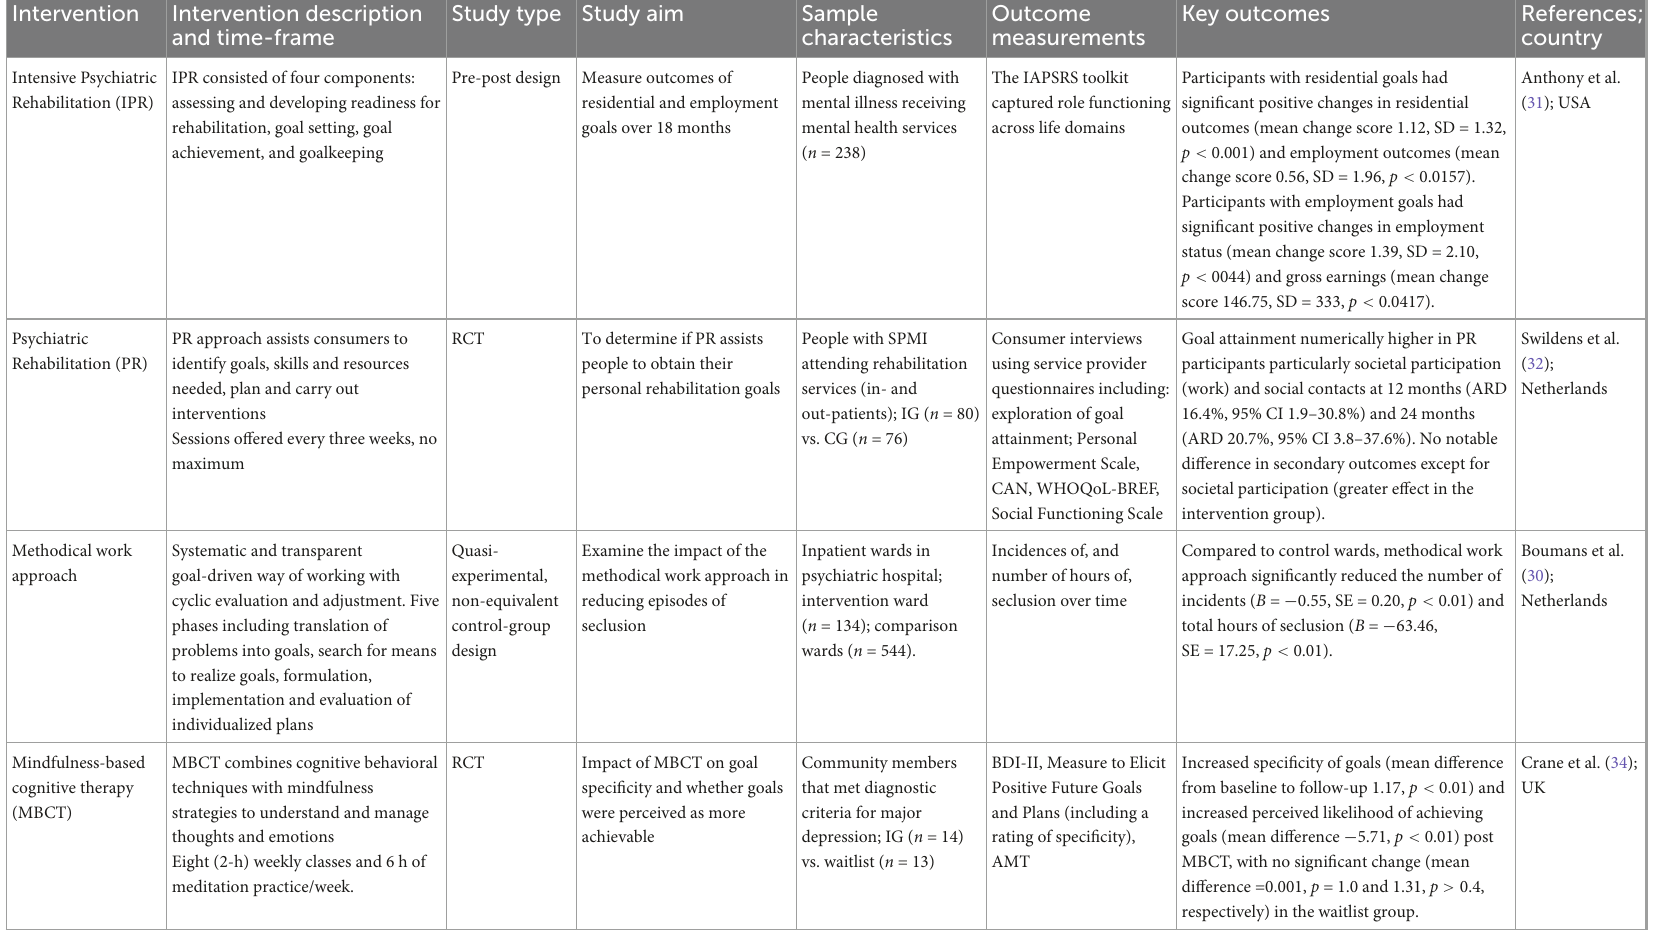
TABLE 1 Goal planning as a central aspect of